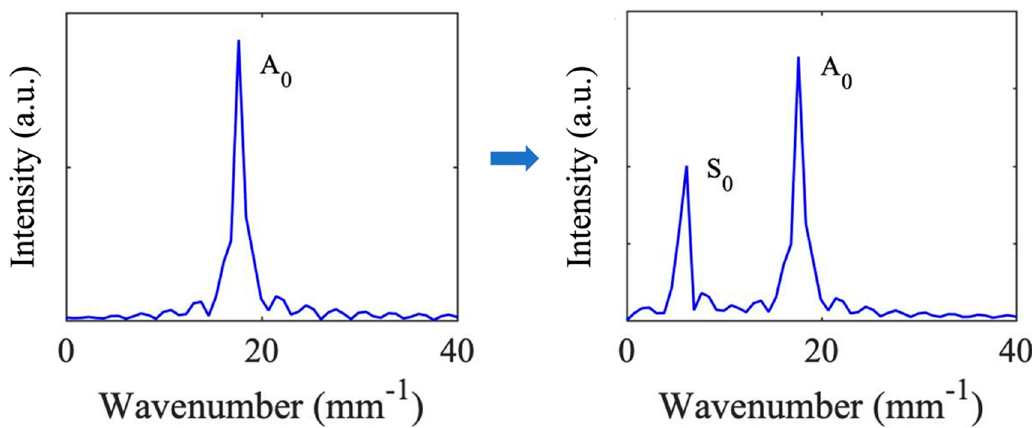
Figure 4. Illustration of the Fourier transformation of mode conversion of an A 0 incident Lamb mode into both A 0 and S 0 modes after traversing the asymmetric-pillared meta-plate at 5 MHz. The figures show the discrete fast Fourier Transformation (FFT) of the out-of-plane displacement within an area on top of the plate. The left figure corresponds to the incident A 0 Lamb wave and the right figure refers to the transmitted wave containing both of the S 0 and A 0 Lamb modes.